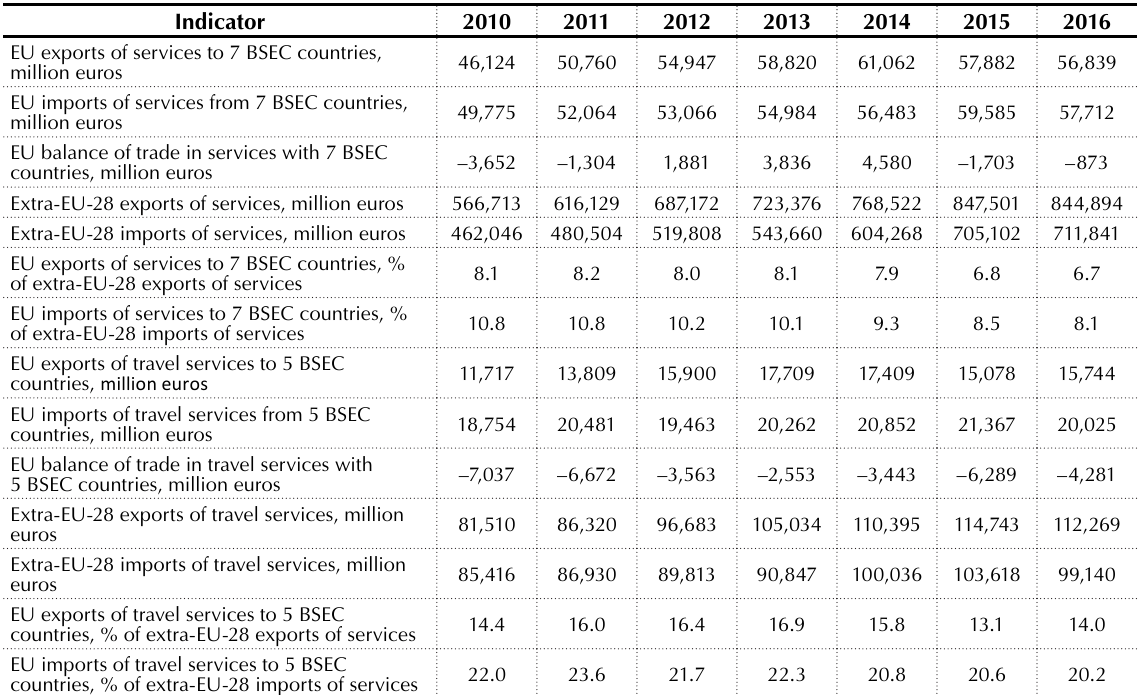
Source: Eurostat and authors’